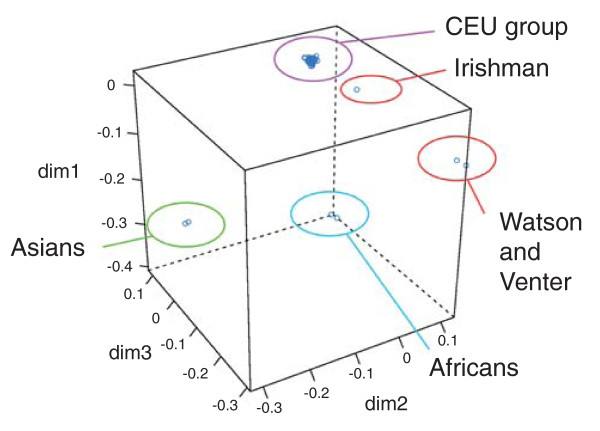
Multidimensional scaling plot illustrating the Irish individual's relationship to the CEU HapMap individuals and other previously sequenced genomes.